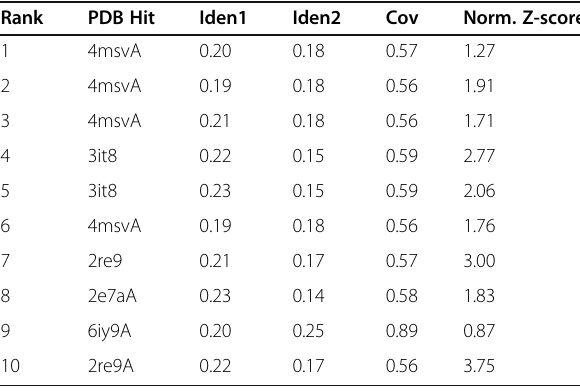
Table 1 Top 10 threading templates used by I-TASSER